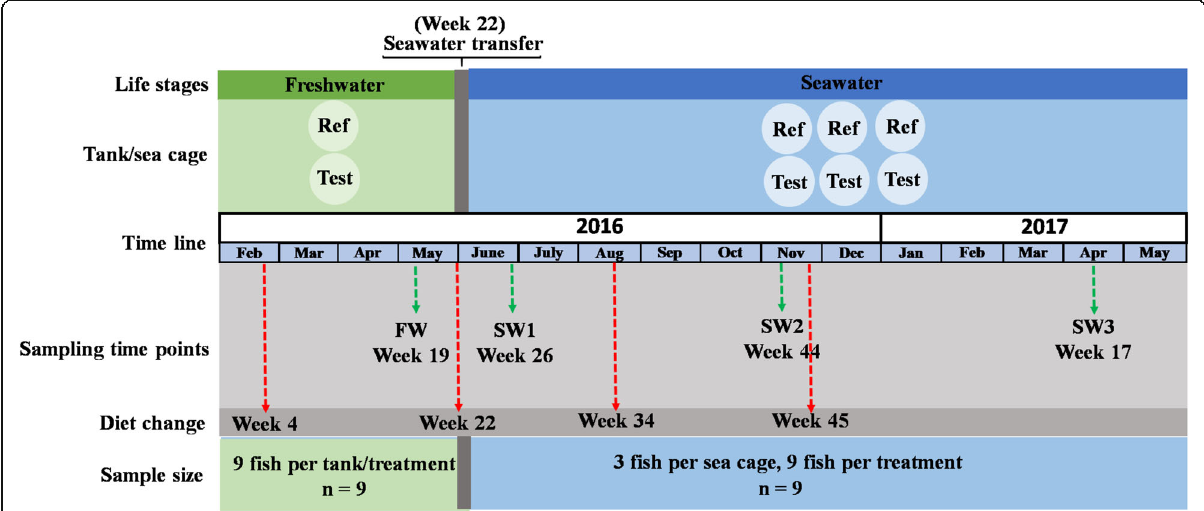
Fig. 6 Outline of the sampling program. The four diet series were changed at week 4, week 22, week 34 and week 45, respectively (Diet composition see Table